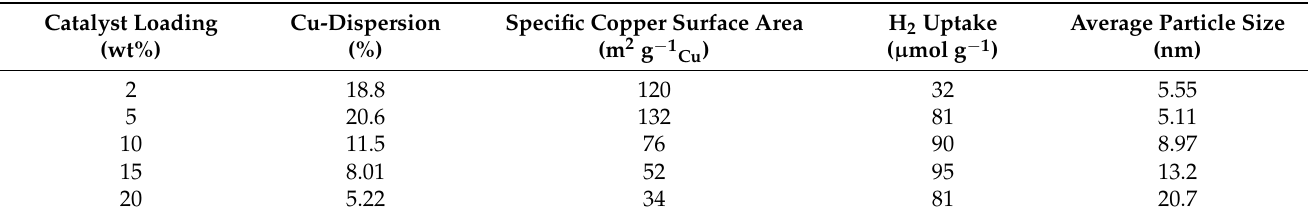
Table 3. Percentage dispersion, average particle size, metal surface area, and H 2 uptake of various Cu/SiO 2 catalysts from N 2 O